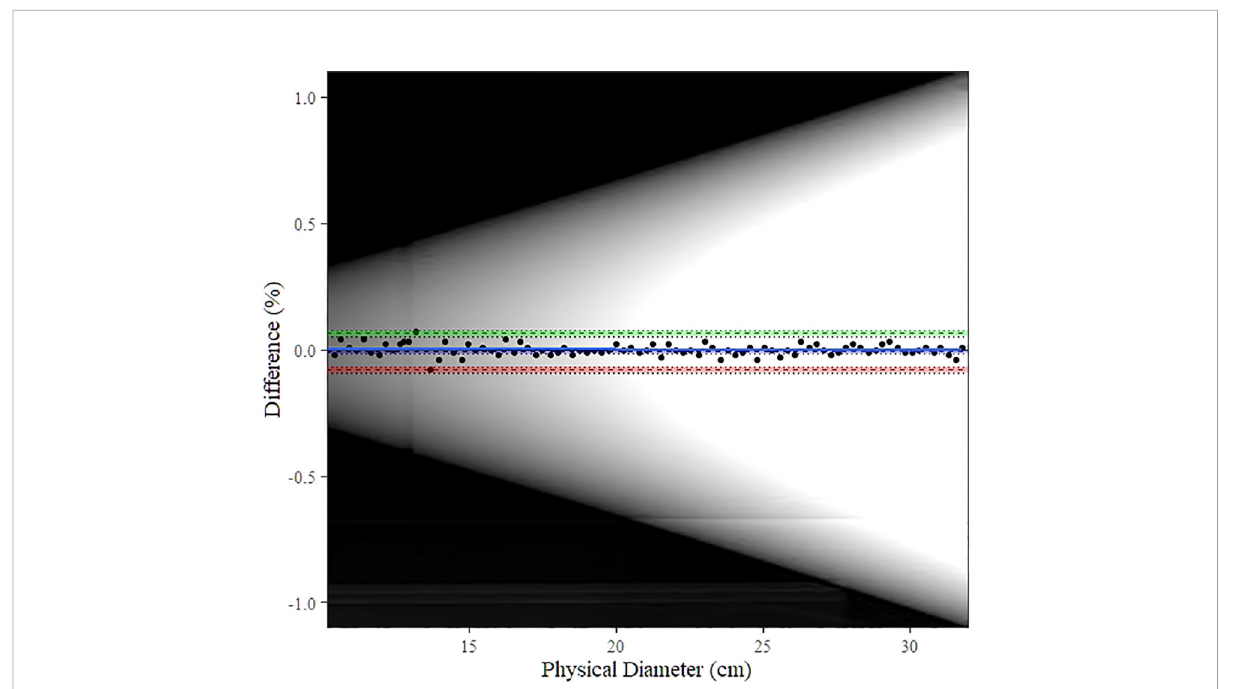
FIGURE 5 Bland – Altman plot for automatic D W computation vs. physical (actual) diameter. The blue line shows the bias estimate with con fi dence interval (CI) as a blue band. Upper and lower limits of agreement (LoA) are depicted as dashed lines with colored bands as CI (upper LoA ’ s CI: green, lower LoA ’ s CI: red). The background image is the scout image of our water- fi lled funnel